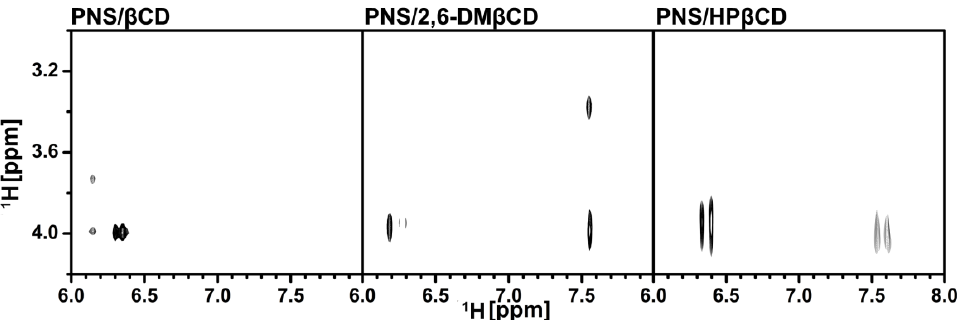
Figure 4. Two-dimensional ROESY spectra of the freeze-dried inclusion complexes.